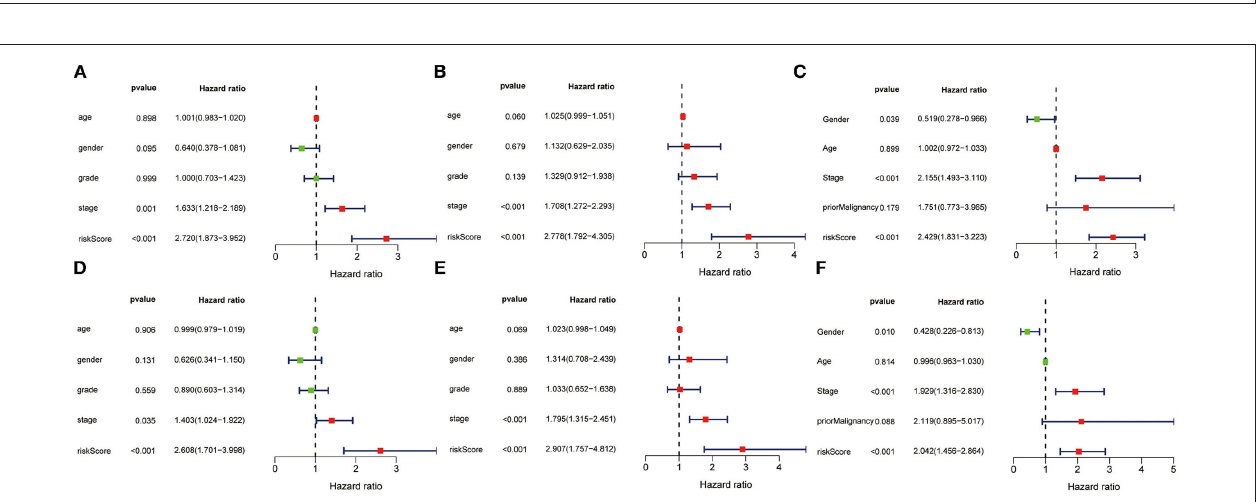
FIGURE 10 | Correlation analysis between clinical feature and risk score. The distribution of risk score in different survival statue (A) , clinical stage (B) , histologic Grade (C) , T stage (D) based on TCGA cohort. The distribution of risk score in different survival statue (E) , clinical stage (F) .